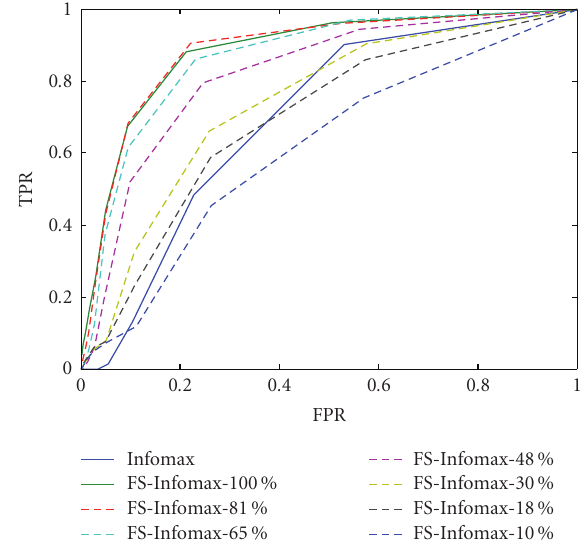
Figure 2: ROC plots for detection of the superimposed activation in the hybrid fMRI data with FS-Infomax incorporating a priori ac- tivation templates overlapping with the true activation region to di ff erent degrees (100%–10%), and ROC plot for detection of the superimposed activation with Infomax